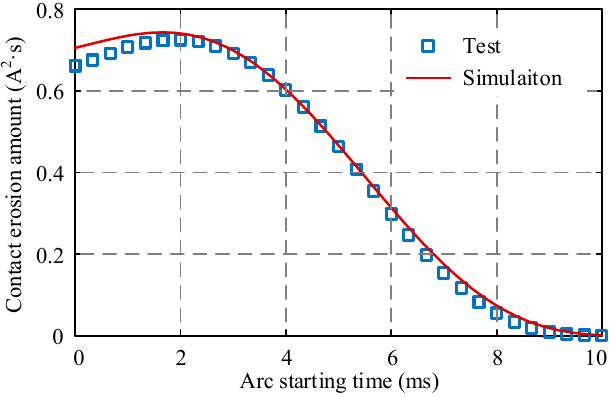
Figure 14. Contact erosion amount curve.